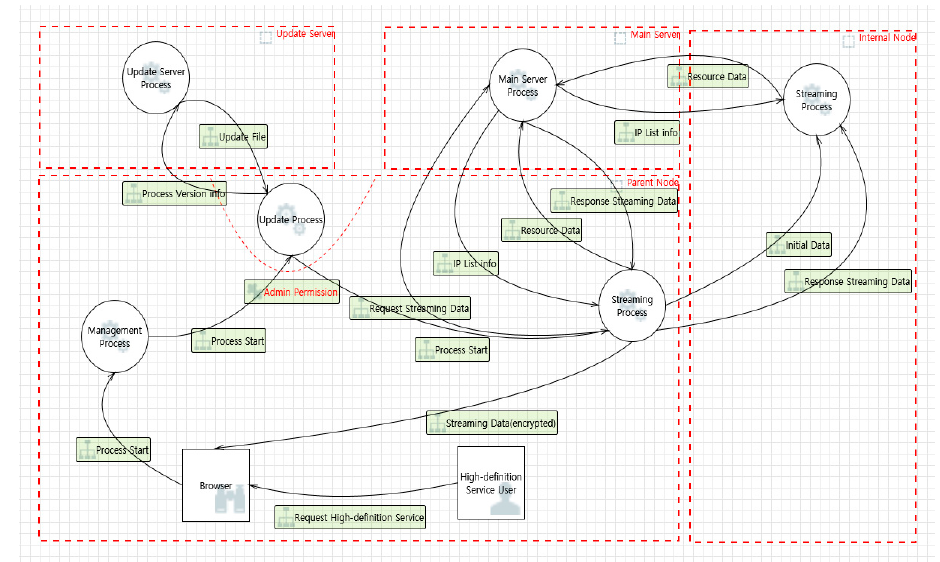
Figure 8. DFD of a tree-structure-based grid computing system.